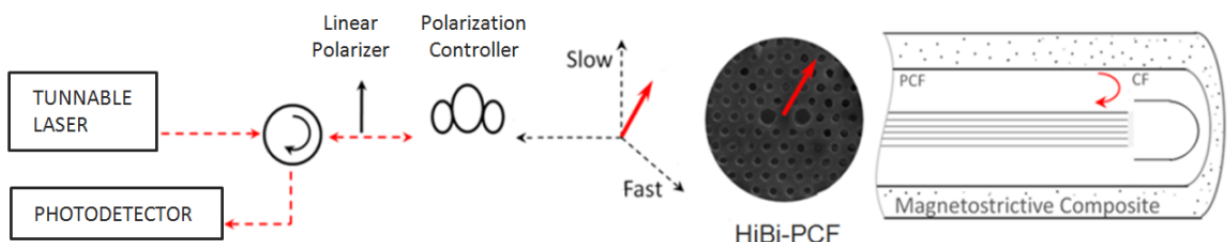
Figure 1. Schematic representation of the interferometric HiBi photonic crystal fiber